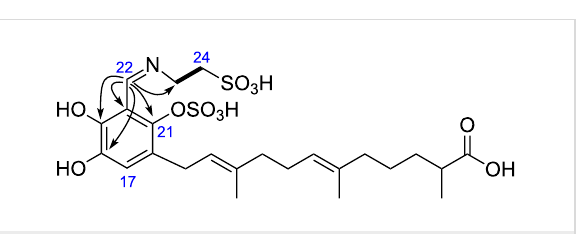
Figure 3: Selected 1 H, 13 C-HMBC correlations (H → C) and 1 H, 1 H- COSY correlation (bold line) observed for siphonodictyal E1 ( 1 ).